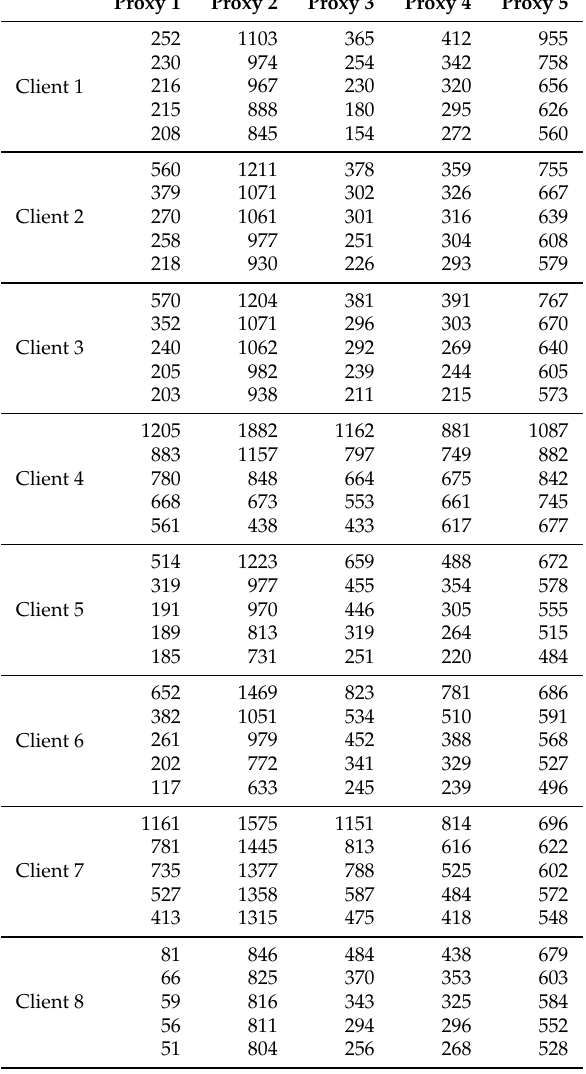
Table A1. Numerical values of boxplots depicted in Figure 2. For each cell from top to bottom: Maximum, Q 3, Q 2, Q 1 and minimum. Values are in